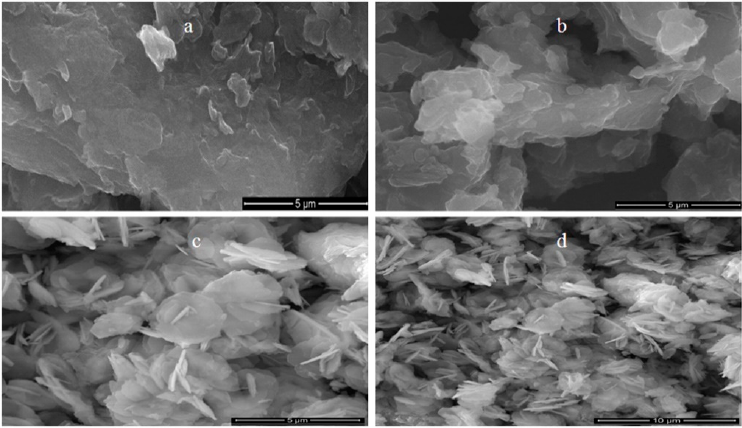
Figure3. Scanningelectronmicroscopy(SEM)imagesof( a , b )preparedgrapheneand( c , d Figure 3. Scanning electron microscopy (SEM) images of (a,b ) prepared graphene and ( c,d ) nanohybrid NH1.